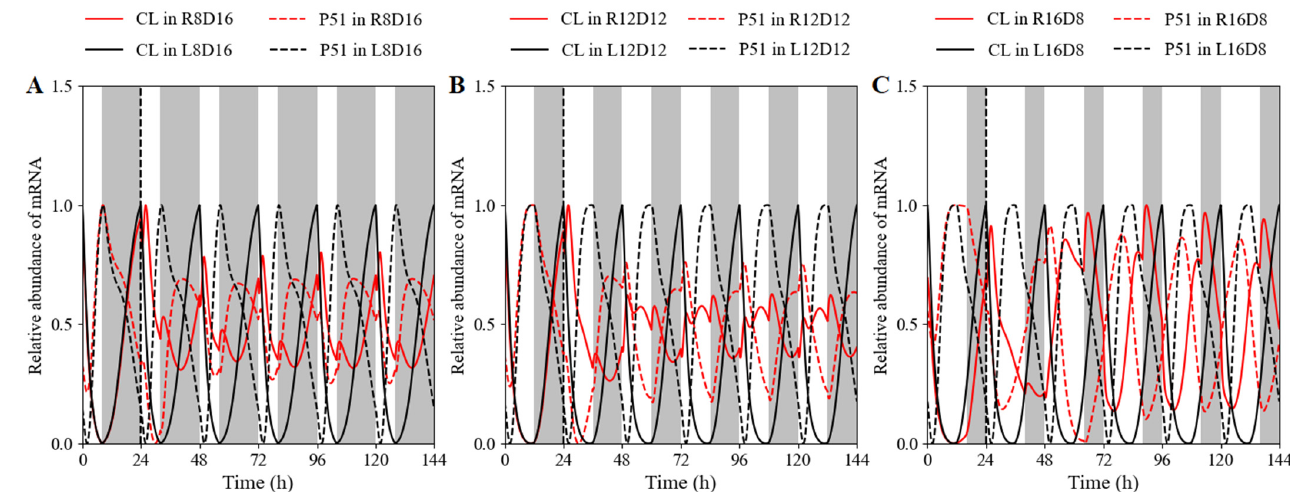
Figure 6. Different dynamic behaviors of the clock elements CL and P51 under red-light cycles in comparison with those under white-light cycles. The simulated expression profiles of CL ( CCA1/LHY ) and P51 ( PRR5/TOC1 ) mRNA on ( A ) short days (8 h light/16 h dark), ( B ) intermediate-light-length days (12 h light/12 h dark), and ( C ) long days (16 h light/8 h dark). R, L, and D indicate red light, white light, and dark, respectively. The solid and dashed lines represent the simulated transcript levels of CL ( CCA1/LHY ) and P51 ( PRR5/TOC1 ), respectively. All values were normalized to their respective maxima.